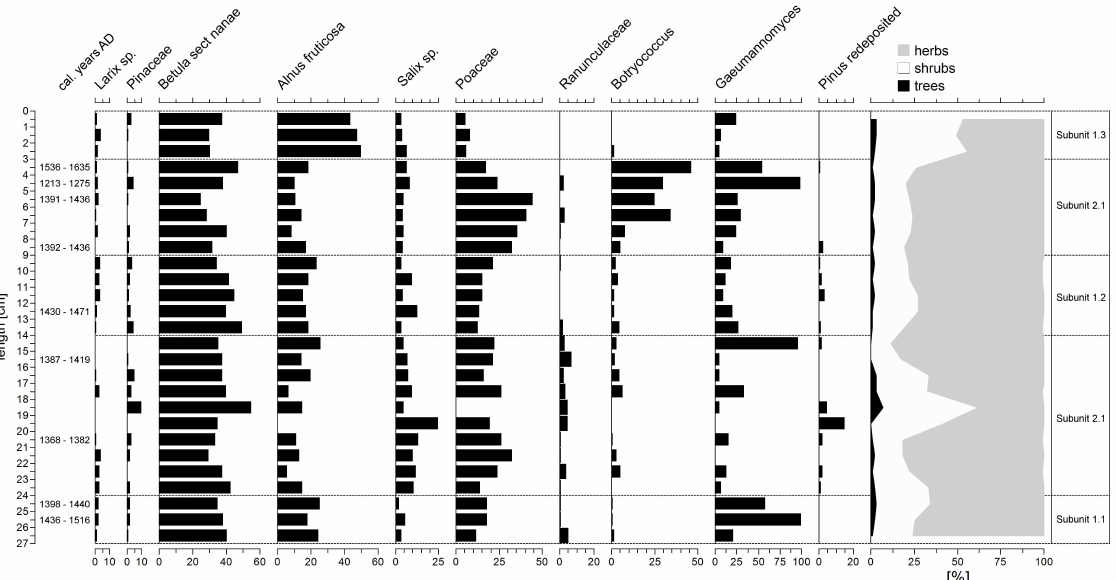
Fig. 7. Pollen percentage plot, showing the important palynomorphs and non-palynomorphs ( Botryococcus and Gaeumannomyces ) from Core C. The percentages of herbs, shrubs, and trees shown in this diagram are calculated from the total pollen grain